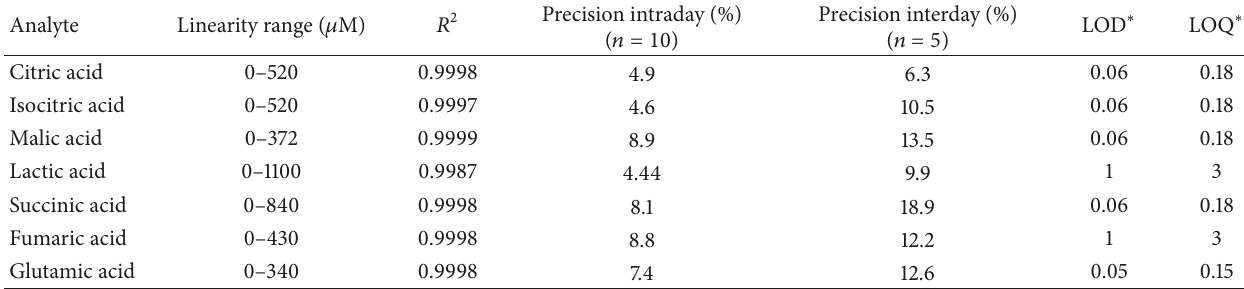
Table 2: Validation data for each analyte in human